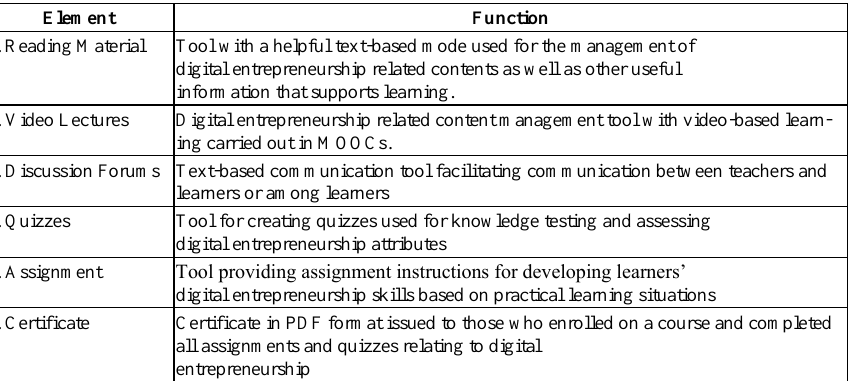
Table 8. Elements of MOOCs-based Learning Management System